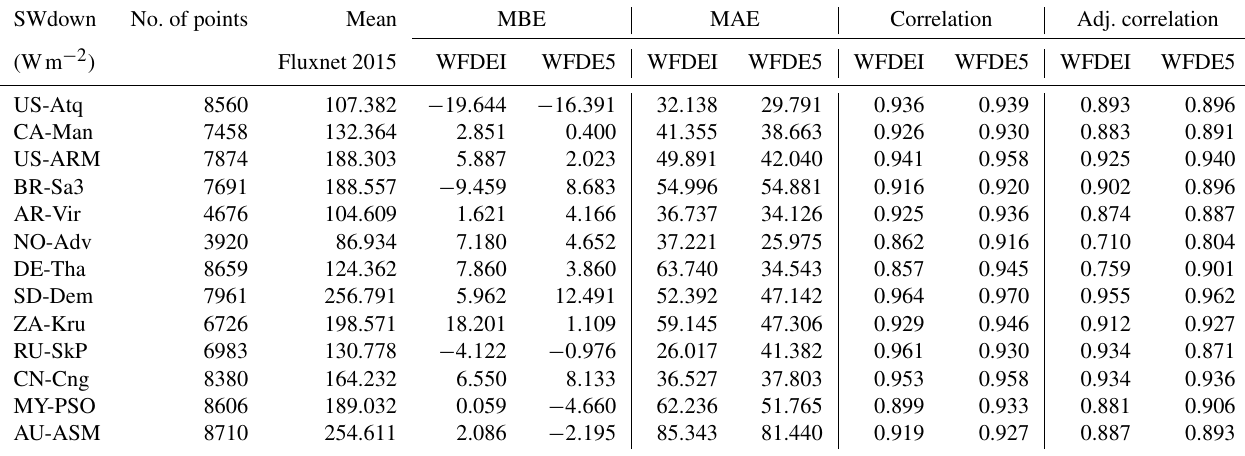
Table A13. SWdown metrics for each FLUXNET2015 site: WFDEI versus FN2015 and WFDE5 versus FN2015 at 3-hourly time steps. SWdown